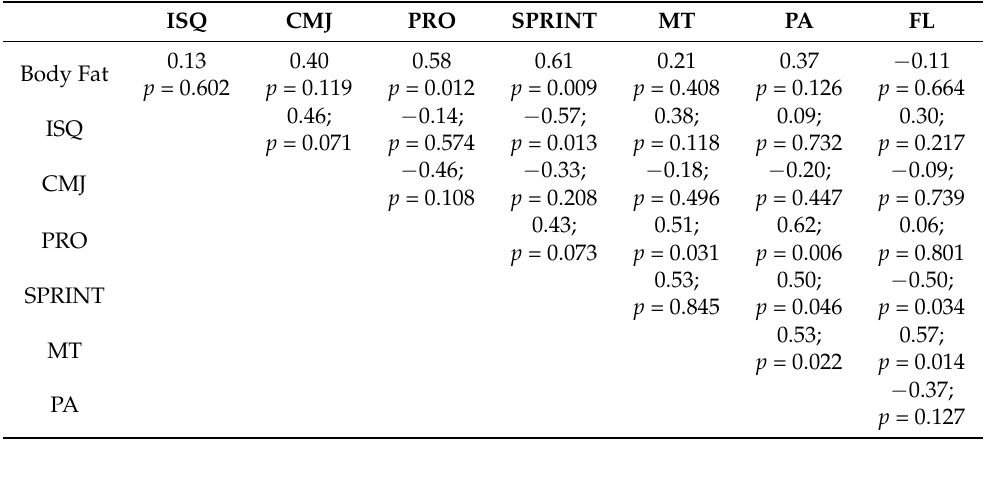
Table 3. Correlations between the different parameters of performance and muscle morphology. ISQ = isometric squat; CMJ = countermovement jump; PRO = pro-agility; SPRINT = 30-m sprint; MT = muscle thickness; PA = pennation angle; FL = fascicle length.